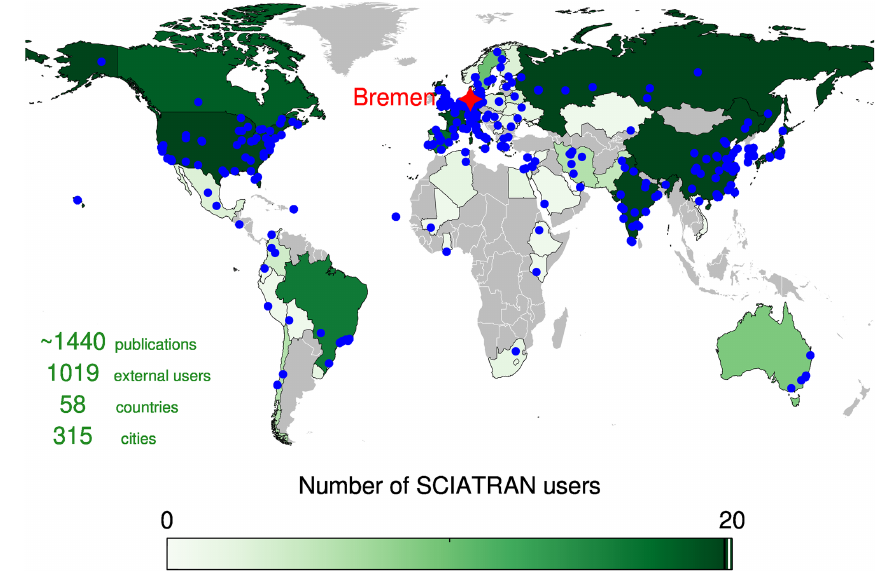
Figure 1. Geographic distribution of SCIATRAN users worldwide as of November 2022. The color indicates the total number of users in each particular country, and the blue dot is the city where SCIATRAN users are located. The red star indicates the city of